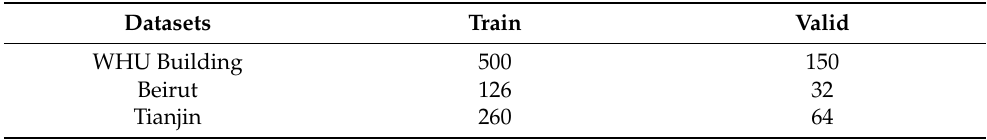
Table 2. The number of samples for different datasets.